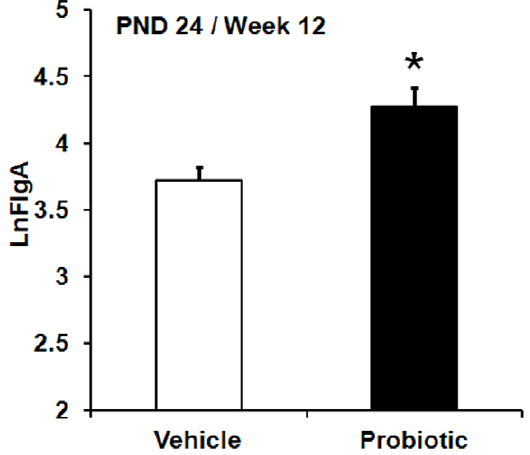
Figure 5. Maternal probiotic intervention and luminal IgA levels. Effect of maternal probiotic intervention on Ln-transformed faecal IgA concentrations (LnFIgA, least squares means + SE). Initial IgA data were expressed as m g/gr faeces. The figure presents aggregated data across test days (PND 24 and 86).The filled bar represents animals born to probiotic-treated dams (n=101) and the hollow bar represents animals born to vehicle-treated dams (n=113). An asterisk (*) indicates statistical significant difference ( p # 0.05).